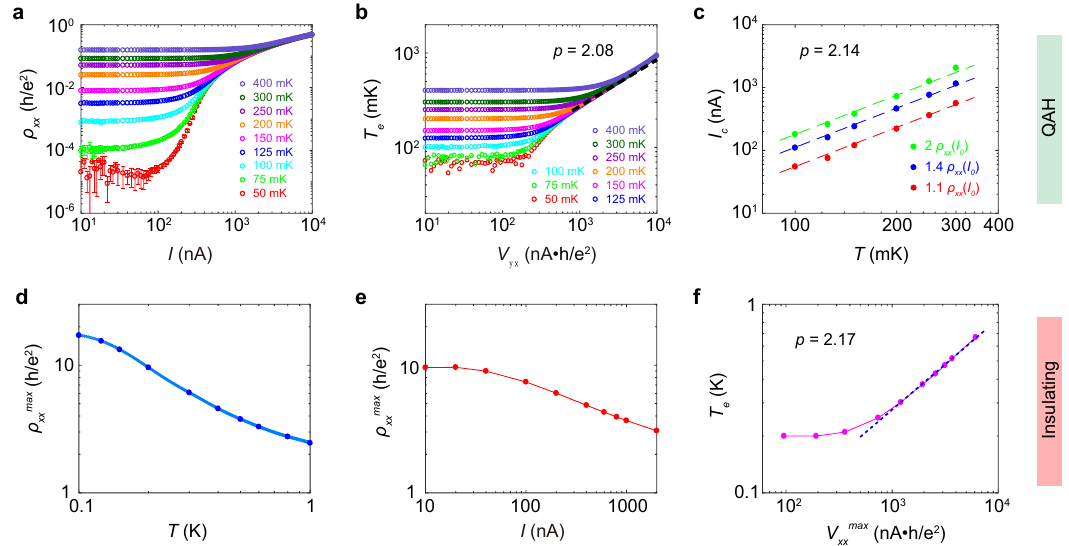
Fig. 3 Critical exponent in the QAH and insulating regimes. a Current dependence of ρ xx at various temperatures. All data are measured under a 1 T magnetic fi eld. b Effective temperature T e vs. Hall voltage V yx . Under small currents, T e equals the bath temperature. As the current increases, the electrons are dominantly thermalized by the electric fi eld, and all data approach a universal curve ( fi tted by the black dashed lines) with a slope of 2/( p + 2) = 0.49, yielding p = 2.08 in the QAH regime. c Temperature dependence of I c . The breakdown current at a given temperature is de fi ned as the current at which ρ xx exceeds m times of ρ xx measured at the base current, where m = 1.1 (red), 1.4 (blue), or 2 (green). The slope of the I c vs. T curve in the log-log plot gives p = 2.14. d Temperature dependence of ρ xx max . The blue dots are obtained from the resistance maximum in the fi eld-dependent ρ xx curves measured at different temperatures and the cyan lines are extrapolated from the blue dots. e Current dependence of ρ xx max . f Effective temperature T e vs. voltage V xx max , under large currents the slope in the log-log plot is 2/( p + 2) = 0.48, yielding p = 2.17 in the insulating curve, the effective temperature plot as a function of V yx can be obtained as shown in Fig. 3b. The linear relationship in the log-log plot at high currents indicates the power-law relationship between (cid:4) V 2 = ð 2 þ p Þ . From the linear fi t of the slope, the T e and V yx : T e yx value of the temperature exponent p is determined to be p = 2.08 ± 0.03.